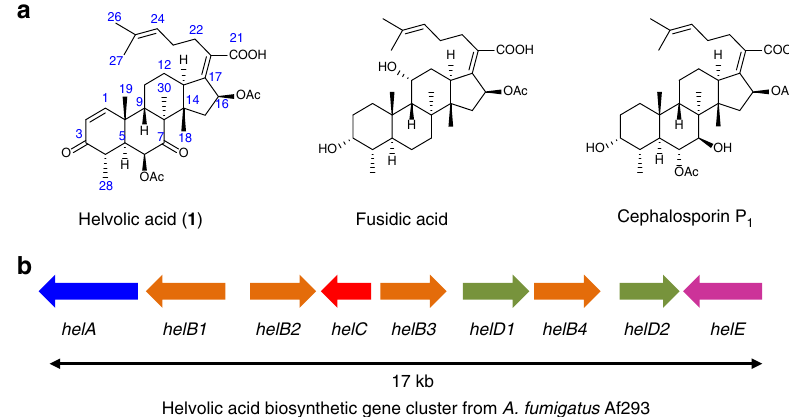
Fig. 1 Representative fusidane-type antibiotics and biosynthetic gene cluster of helvolic acid ( 1 ). a Structures of helvolic acid ( 1 ), fusidic acid and cephalosporin P 1 ; b Gene map of the helvolic acid gene cluster from A. fumigatus Af293 NATURE COMMUNICATIONS | 8: